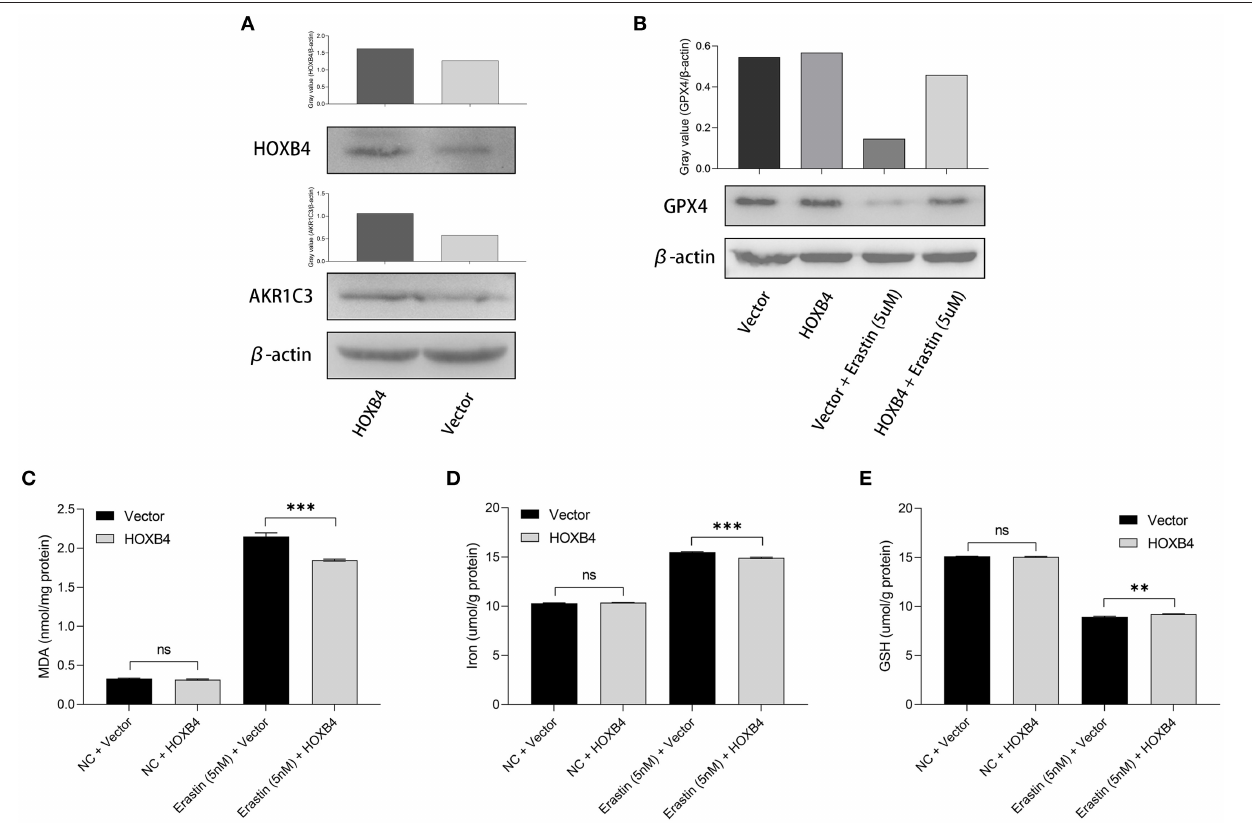
FIGURE 6 | The upregulation of HOXB4 suppressed ferroptosis in H9C2 cells. (A) A HOXB4-overexpression H9C2 cell line was successfully constructed via transient transfection, and AKR1C3 was upregulated in the cells with overexpressed HOXB4. (B) GPX4 was significantly upregulated in the HOXB4-overexpression cells with erastin treatment. (C–E) The overexpression of HOXB4 was significantly associated with the level of malondialdehyde (C) , iron (D) , and glutathione (E) . ** p < 0.01; *** p < 0.001; ns, not